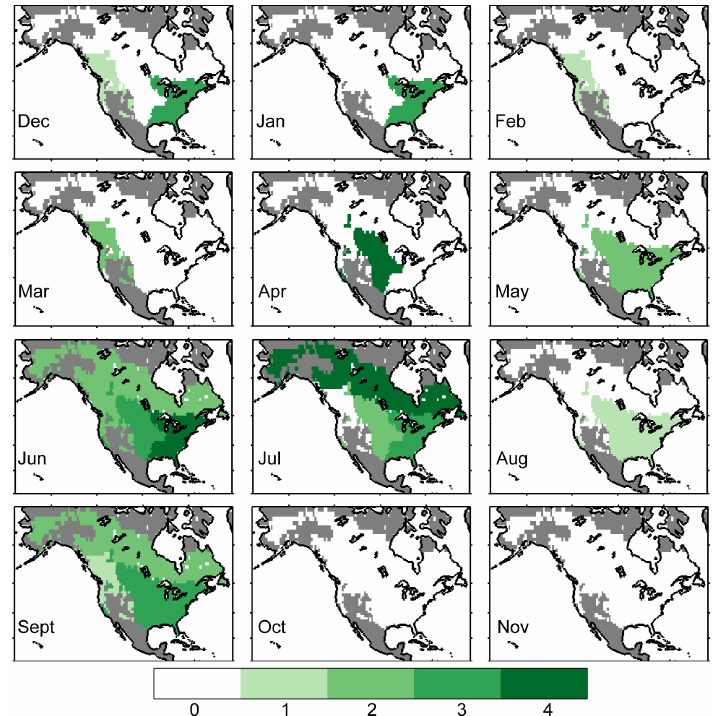
Figure 7. Number of TBMs that are selected for each biome-month in the RD-one- ξε case study. Grey shading represents biomes that were determined to be not sufficiently well constrained by available atmospheric